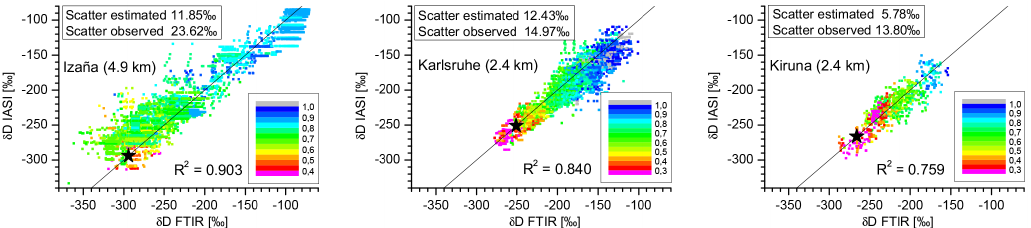
Figure 8. Correlation between the IASI and smoothed FTIR δ D data. Colours denote the individual IASI DOFs, the black star marks the a priori, and the black line shows the 1-to-1